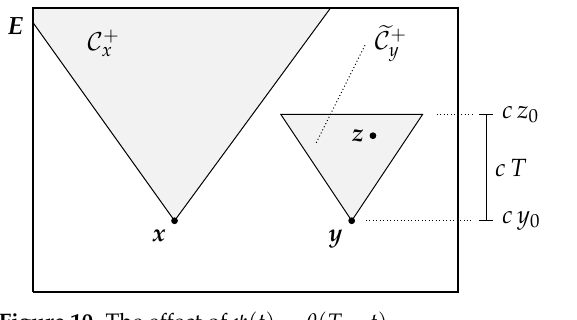
Figure 10. The effect of ψ ( t ) = θ ( T − t ) .